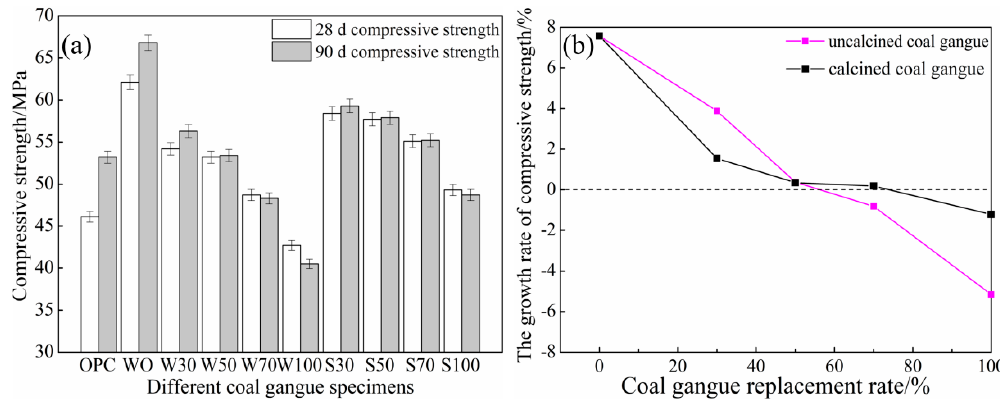
Figure 2. Compressive strength of ( a ) 28 d, 90 d and ( b ) 28 d-90 d growth rate.